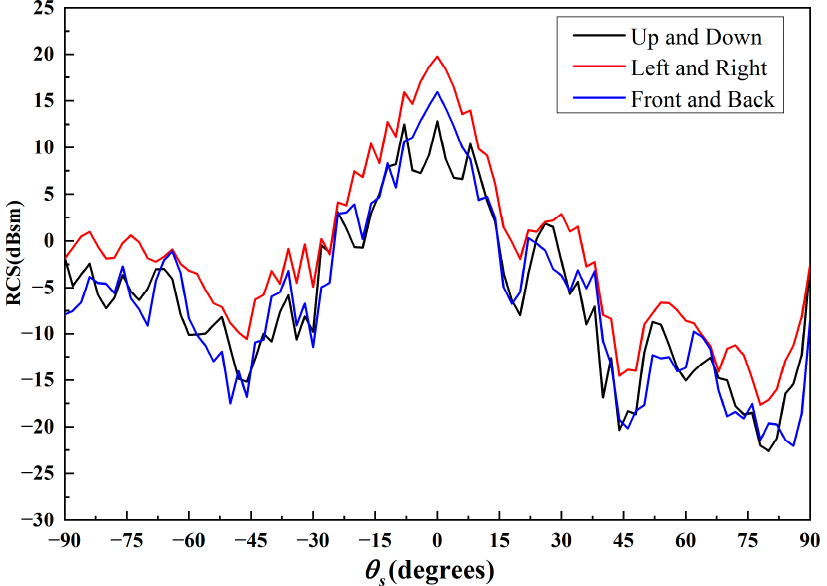
Figure 9. Mono-static RCS for HH polarization of hybrid dielectric and conductor missile-like tar- gets with di ff erent distributions of position in free space.